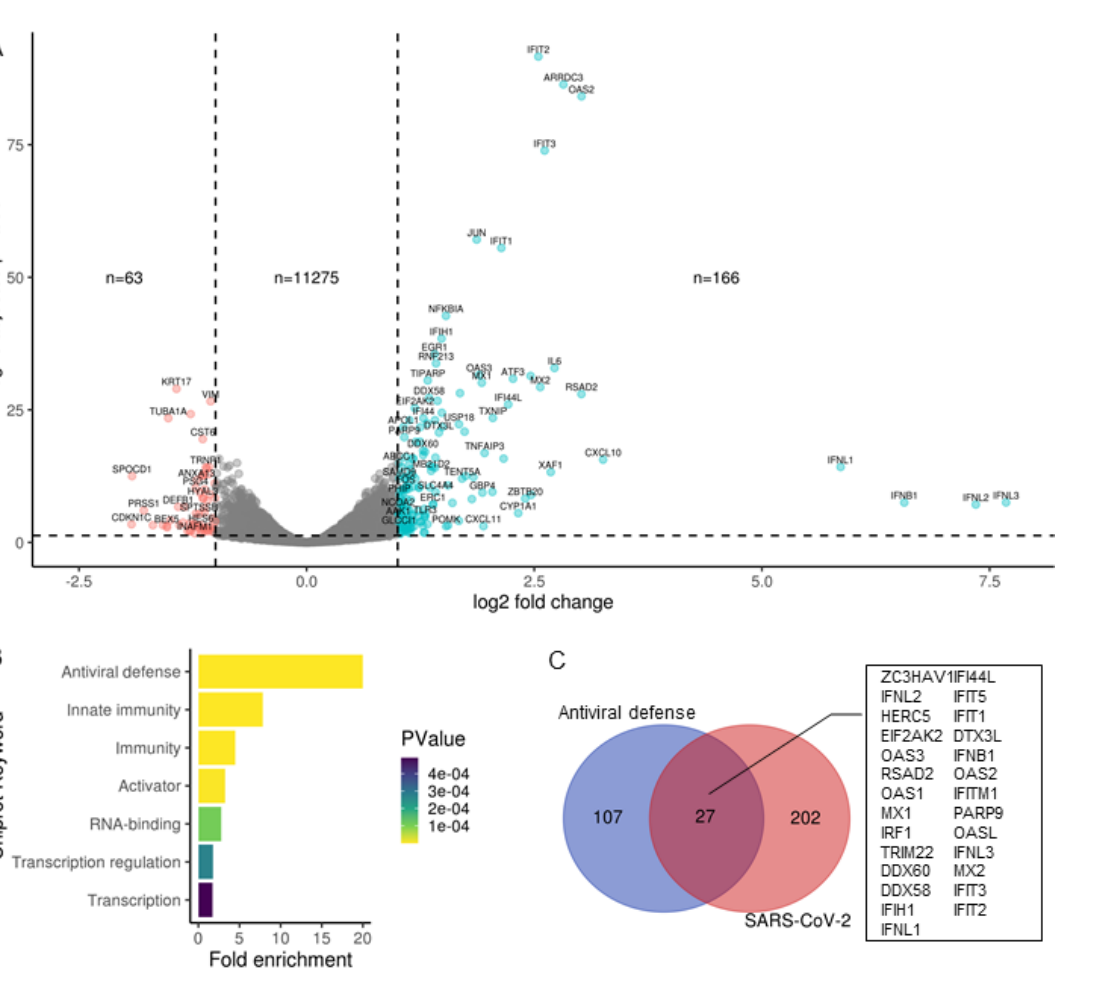
Figure 2. Transcriptional response to SARS-CoV-2 infection of Calu-3 cells is dominated by antiviral defense genes. ( A ) Volcano plot showing global transcriptional changes of ~11,000 genes in SARS-CoV-2 infected Calu-3 cells. Log2FoldChange infected 24 h versus mock. 229 transcripts were differentially expressed (DE) in SARS-CoV-2 infected cells based on the cut-off of p -value < 0.05, log2fold change > 1. ( B ) Significantly altered genes were submitted to https://david.ncifcrf.gov/ (accessed on 23 March 2021) for Functional Annotation Clustering. Here, Uniprot Keywords were summarised using fold enrichment of DE genes, coloured by PValue. ( C ) Common genes between Uniprot “Antiviral Defense” keywords and the 229 SARS-CoV-2 DE genes.